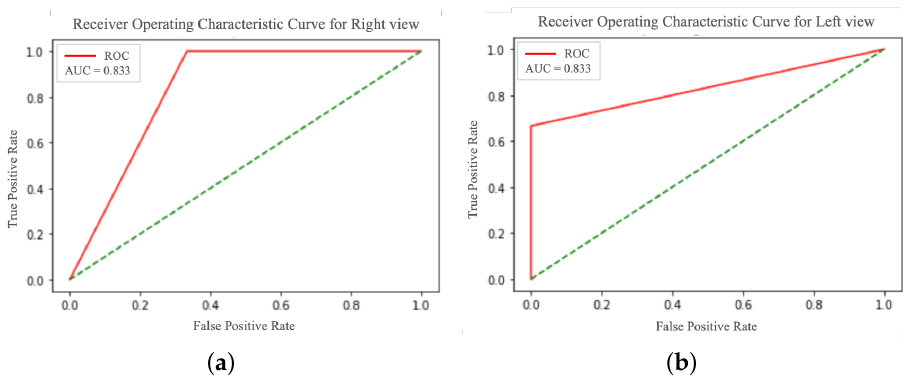
Figure 5. The ROC curve and AUC. ( a ) ROC curve and AUC value of the right oblique view, ( b ) ROC curve and AUC value of the left oblique